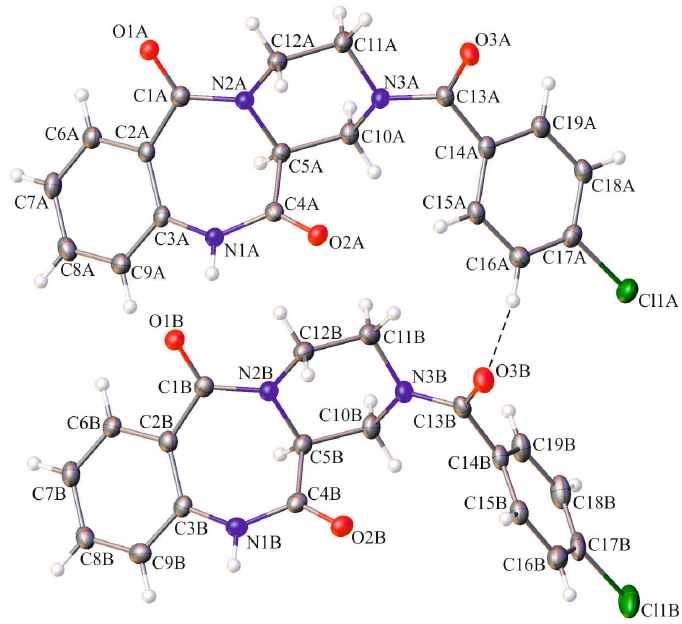
Figure 2. Molecular structure of 4 with crystallographic numbering. Displacement ellipsoids are drawn at the 50% probability level and the H-atoms are shown as small spheres of arbitrary radius. The weak intermolecular C–H···O hydrogen bond is represented by a dashed line.